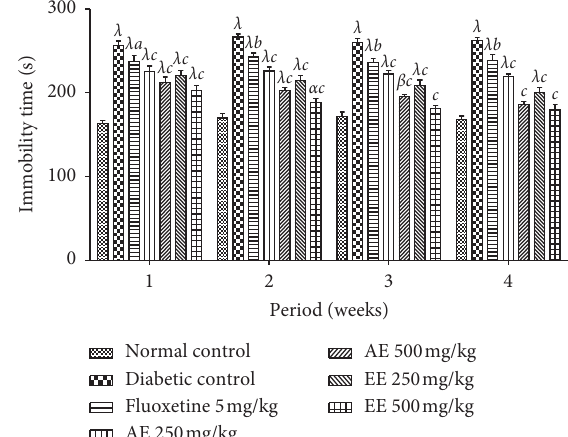
Figure 11: Effects the aqueous (AE) and ethanol (EE) extracts of Dissotis thollonii on the immobility time in the force swimming test during 5min. Values are expressed as mean ± SEM for six animals and analyzed by two-way ANOVA followed by Bonferroni post hoc test. β p < 0 . 01, λ p < 0 . 001 when compared with the normal control and a p < 0 . 05, b p < 0 . 01, c p < 0 . 001 when compared with the diabetic control; s: seconds.